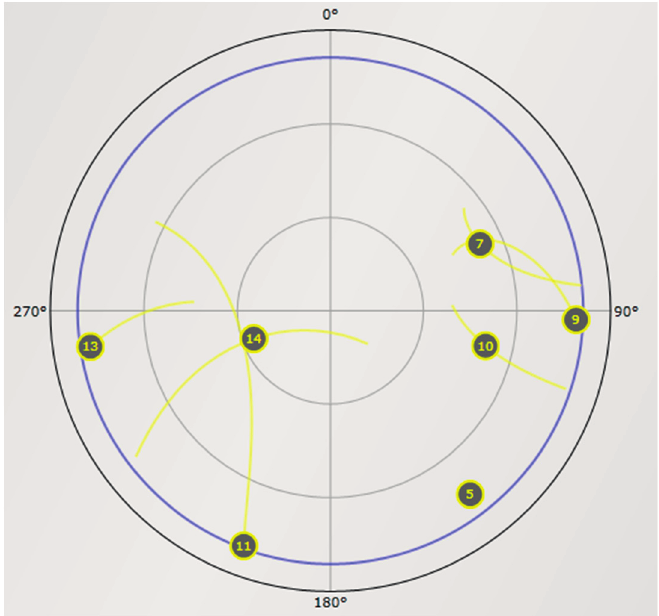
Figure 8. Sky-plot of BeiDou satellite navigation system at UTC time 9:30 AM at Finnish Geodetic Institute with an elevation cut-off angle of 10 0